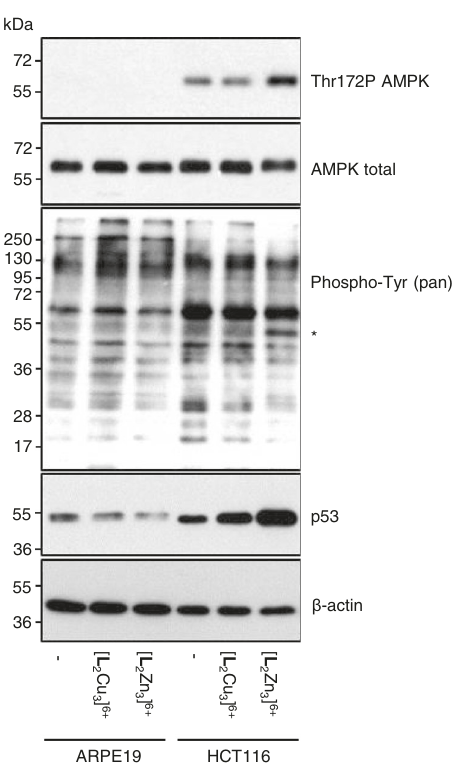
Fig. 10 Immunoblots showing the differential effects of [L 2 Cu 3 ] 6 + and [L 2 Zn 3 ] 6 + treatment of HCT116 cancer cells and ARPE-19 non-cancer cells on key cellular proteins associated with cellular and metabolic stress. Representative immunoblot images of the indicated proteins following cell exposure to 5 µ M [ L 2 Cu 3 ] 6 + or [ L 2 Zn 3 ] 6 + for 40 h. Tyrosine phosphorylated proteins are indicated using a pan- phospho-Tyr antibody; β -actin as a loading control. Similar results were obtained in a minimum of n = 2 independent